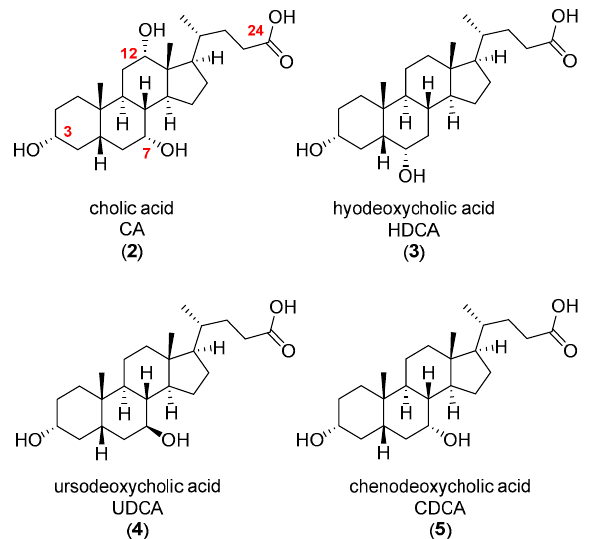
Figure 2. Structures of cholic ( 2 ), hyodeoxycholic ( 3 ), ursodeoxycholic ( 4 ) and chenodeoxycholic ( 5 ) acids.